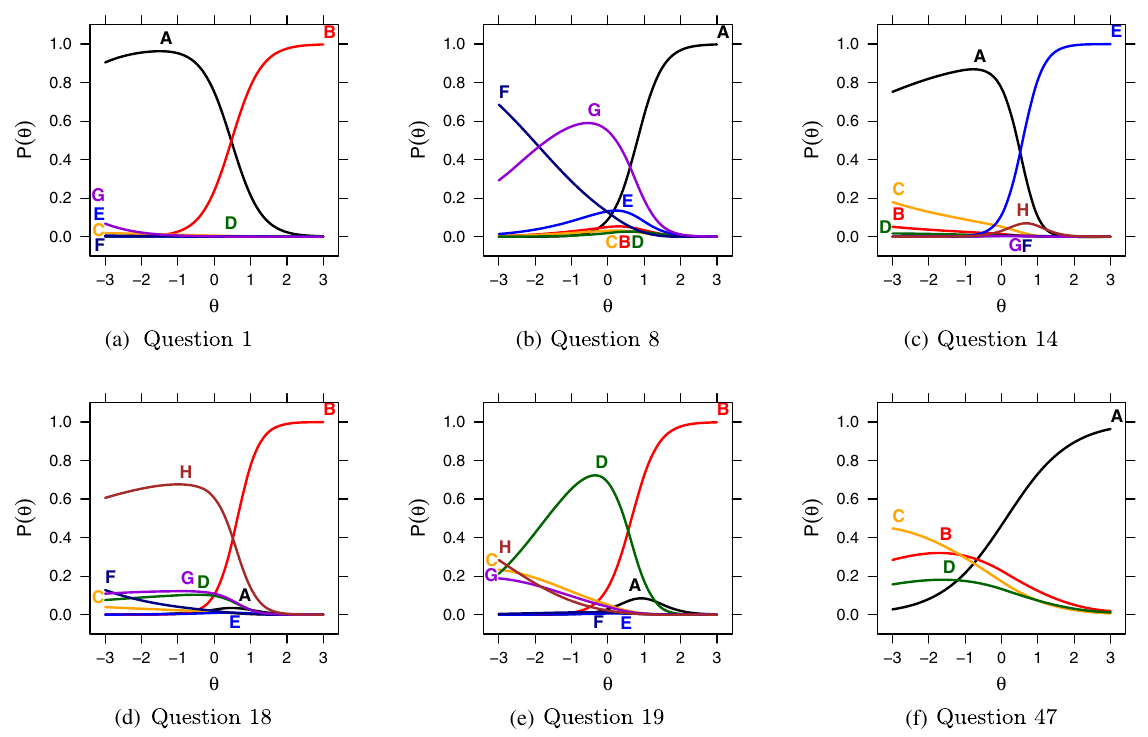
FIG. 3. IRT plots from the 2PL-NRM nested logit model for questions 1, 8, 14, 18, 19, and 47: probability of choosing each response as a function of the person parameter θ (representing overall understanding of Newtonian